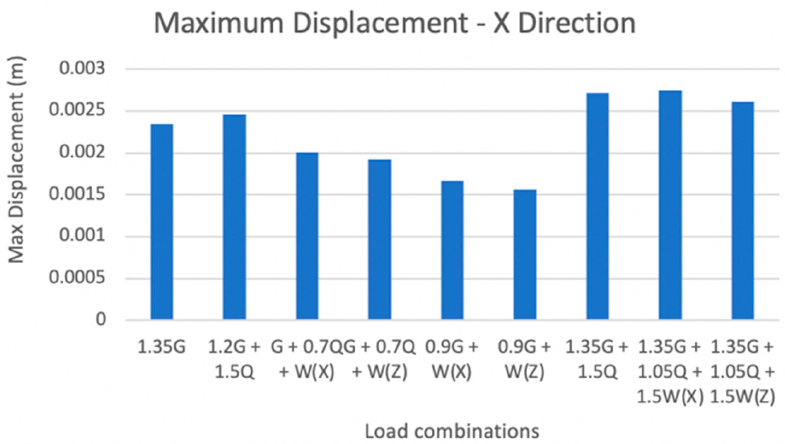
Figure 7. Maximum lateral displacement of DFF in the X direction for each load combination.